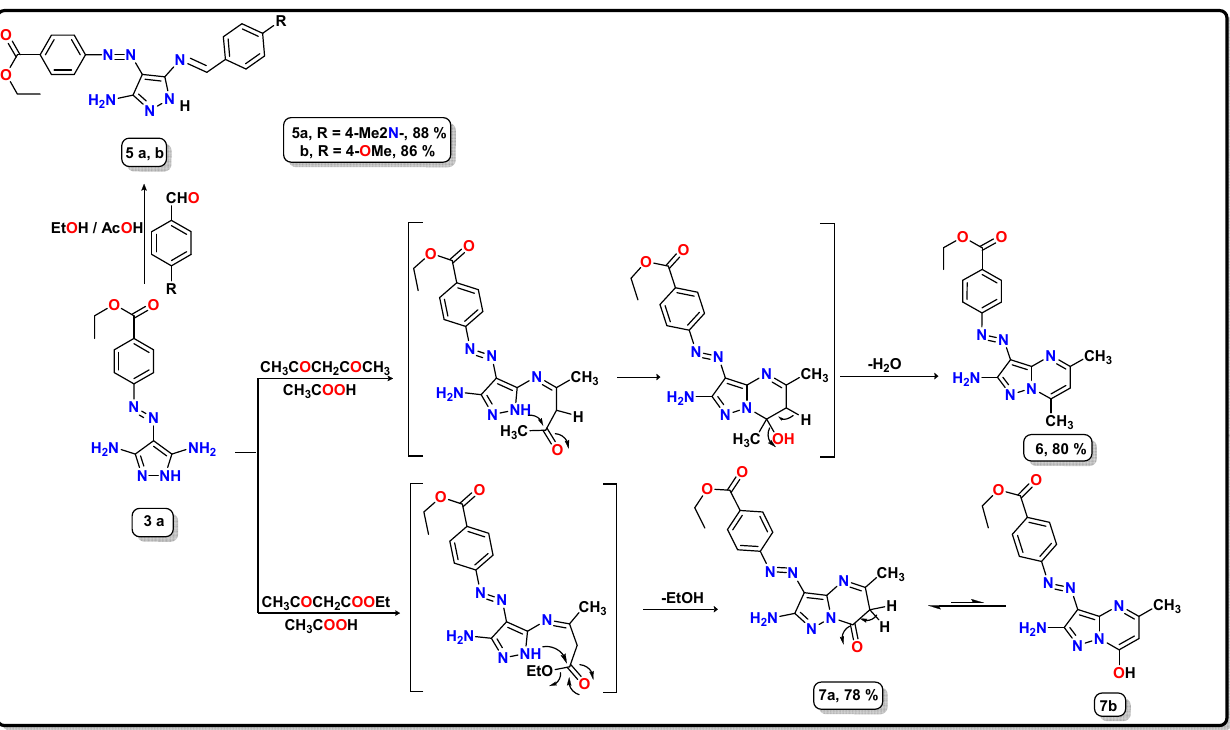
Scheme 2. Synthesis of pyrazole Schiff bases 5a,b and suggested pathway to produce 5-methylpy- razolo[1,5- a ]pyrimidine derivatives 6 and 7